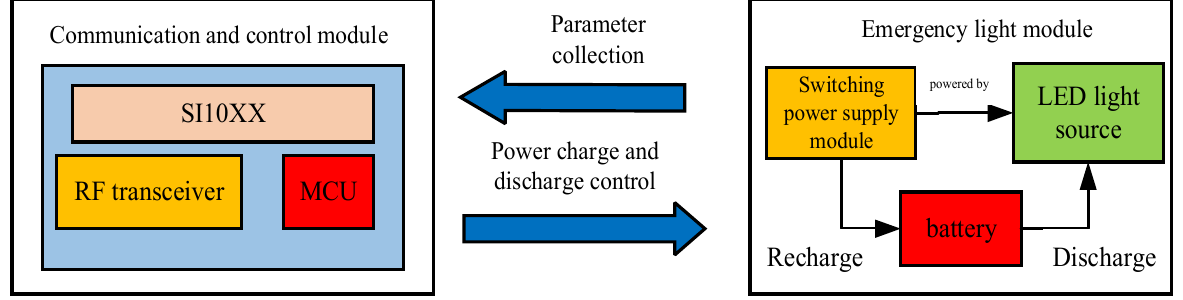
Figure 4. Internal module composition of the emergency light.